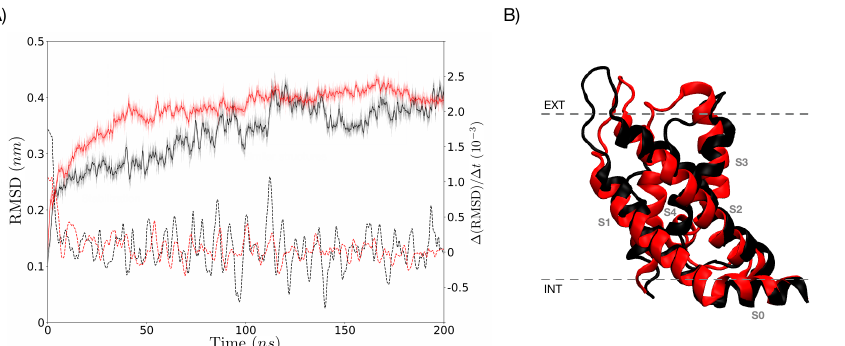
Figure 2. Comparison of both VSD structures after 200 ns of simulation without any external (cid:126) E . ( A ) RMSD (after a lsq fit) as a function of time for the VSD in Box 1 (thin black line) and Box 2 (thin red line). RMSD values after a LOWESS smoothing appear in thick black and red lines. The derivative along time of the RMSD is shown using dashed lines. As seen, the RMSD derivative stabilizes very rapidly, fluctuating in the order of 10 − 3 nm, from 5 ns, up to the end of the simulation, denoting that the molecular systems have reached to equilibrium. ( B ) Overlapping with a RMSD = 0.4364 nm of the final conformations for both VSD structures in Box 1 (in black) and Box 2 (in red) after 200 ns of simulation without any external (cid:126) E